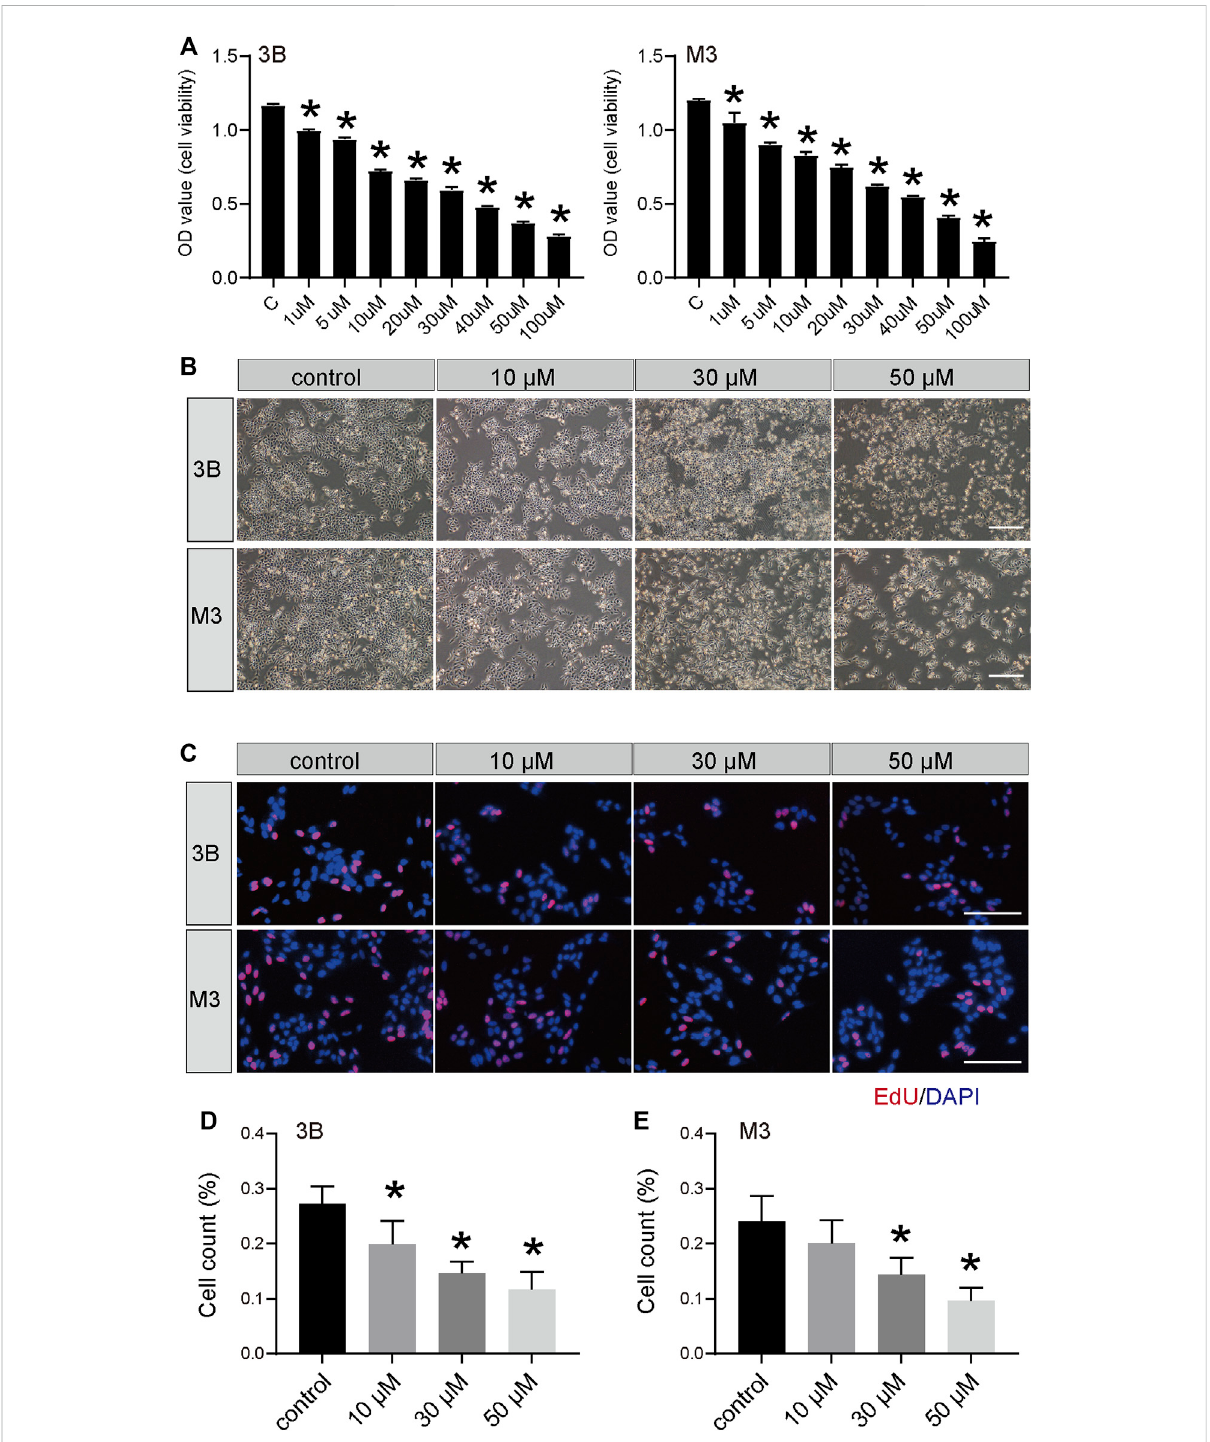
FIGURE 1 STAinhibitsthesurvivalofHCCcells. (A) CellviabilityofHep3BandHCCLM3cellstreatedwithSTAatindicateconcentrationwasdeterminedby CCK8 method, DMSO was used as control. (B) The morphology of Hep3B and HCCLM3 cells treating with STA in different concentration for 48 h. (C – E) EdU-positive Hep3B and HCCLM3 cells after treating with STA for 48 h. Scale bar = 100 μ m. Data shown are means ± SD; n = 3. * p < 0.05, signi fi cantly from control